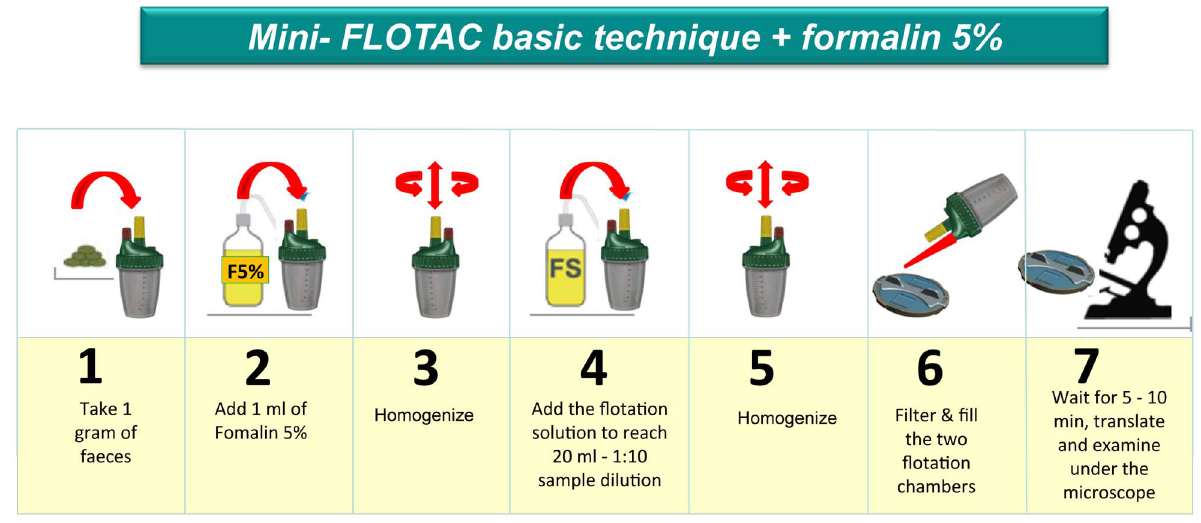
Figure 2. The steps of the mini-FLOTAC technique.